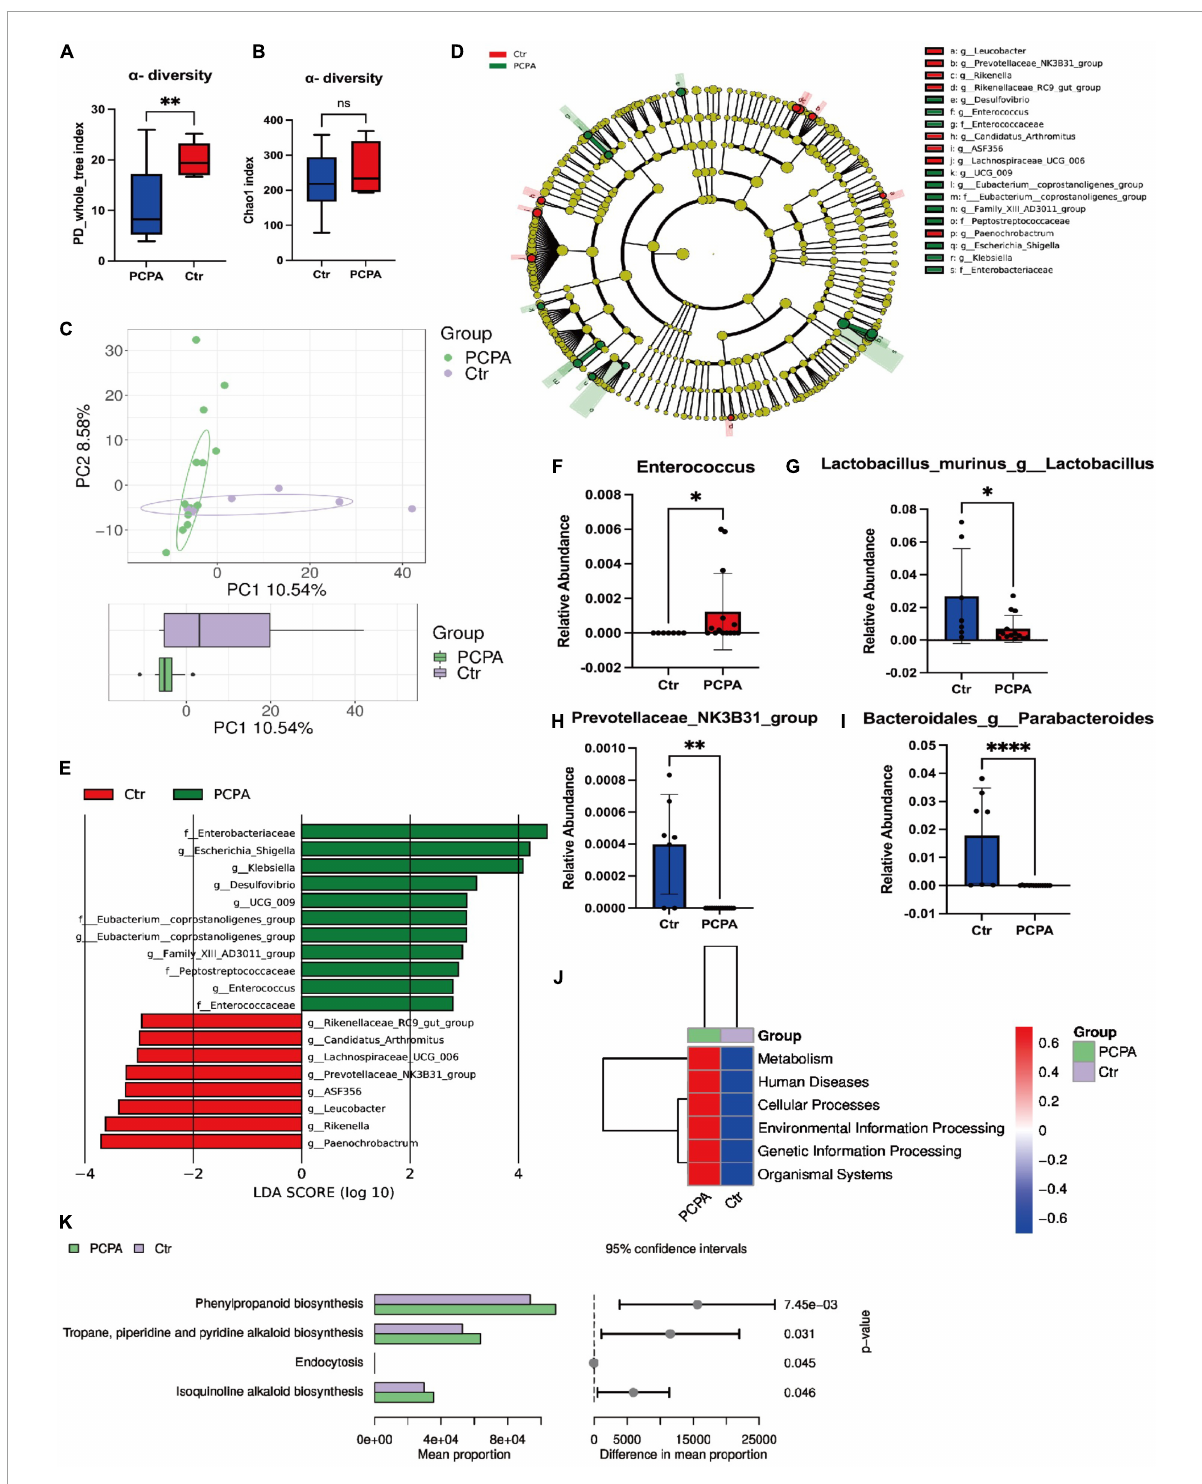
FIGURE2 Para-chlorophenylalanine (PCPA) treatment induced gut microbiota alternation in mice. (A) α -diversity Chao1 index. (B) α -diversity PD Whole Tree Index. (C) Boxplot of principal component analysis (PCA). (D,E) Linear discriminant analysis Effect Size (LEfSe) analysis. (F) Relative abundance of the species g_Parabacteroides. (G) Relative abundance of the species g_Lactobacillus. (H) Relative abundance of the species g_Escherichia-Shigella. (I) Relative abundance of the family Enterobacteriaceae. (J) Relative abundance of the family Peptostreptococcaceae. (K) Relative abundance of the family Enterococcaceae. (L–N) KEGG analysis. Data are presented as the mean ± SEM. ∗ P < 0.05; ∗ P < 0.01; ∗∗∗∗ P < 0.0001; ns, not